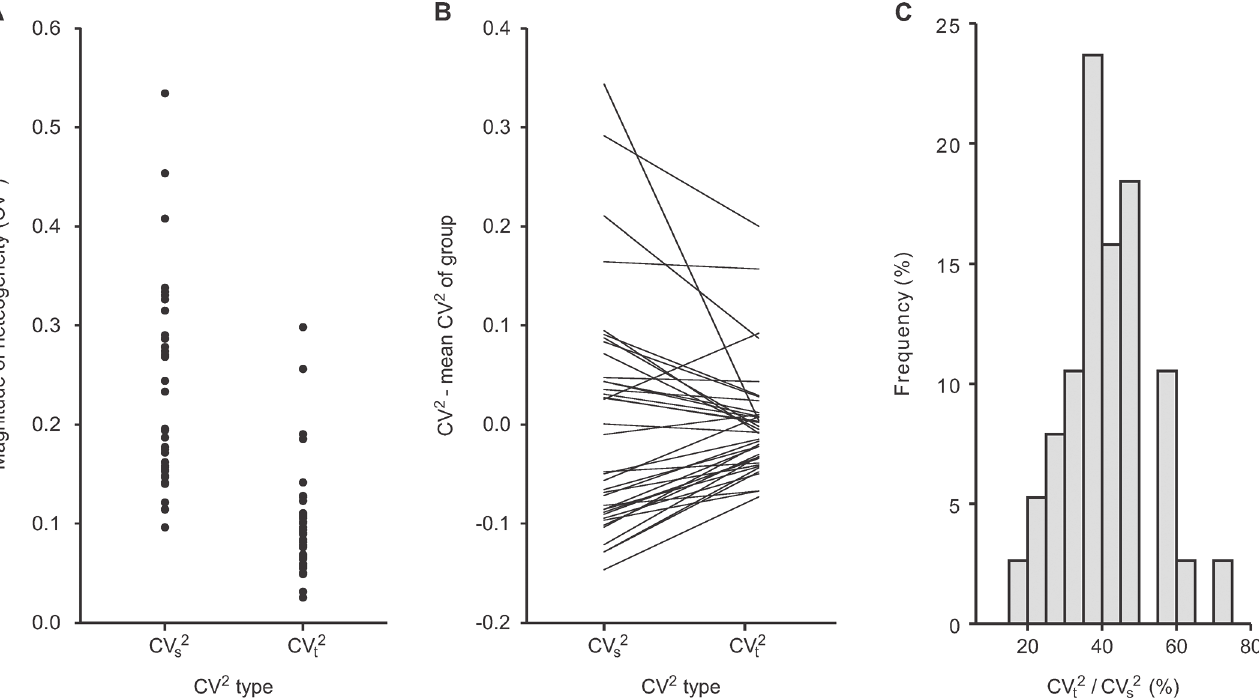
Fig 3. Comparison between estimates of noise-free heterogeneity ( CV t2 ) in pulmonary perfusion and the corresponding overall heterogeneity of PET scans including noise ( CV s2 ). A: Paired magnitudes of CV s2 and CV t2 of perfusion. B: Comparison of CV s2 and CV t2 relative to each parameter ’ s mean showing that the noise included in CV s2 affected the order of values compared to CV t2 . That difference in the order of values would for example affect rank sum tests and result in a higher statistical power for tests performed with CV t2 compared to CV s2 . In general, noise affecting a parameter lowers its accuracy for comparisons. C: CV t2 over CV s2 as relative fraction of the noise-free heterogeneity compared to the overall heterogeneity of PET scans.